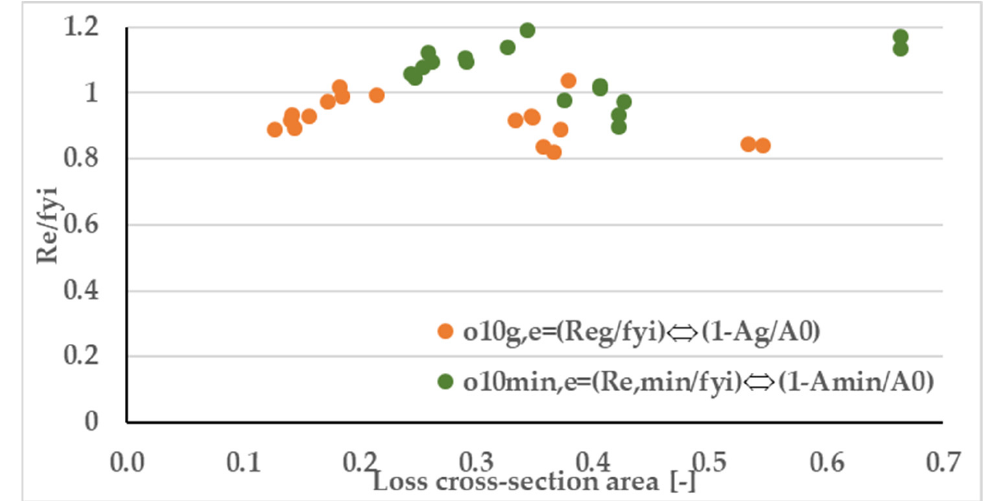
Figure 18. Dependence of the yield strength ratio of the corroded to non-corroded sample (R e,g /f t ) and (R e,min /f t ) on the relevant loss of cross-sectional area of reinforcement ϕ 10 ((1 − A g /A 0 ) or (1 − A min /A 0 )).